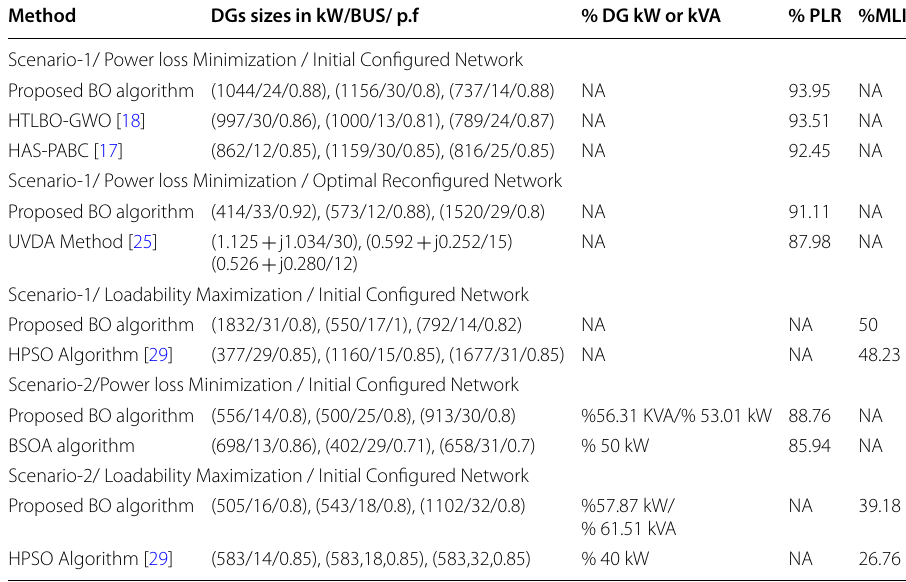
Table 5 Comparison results of 33 bus